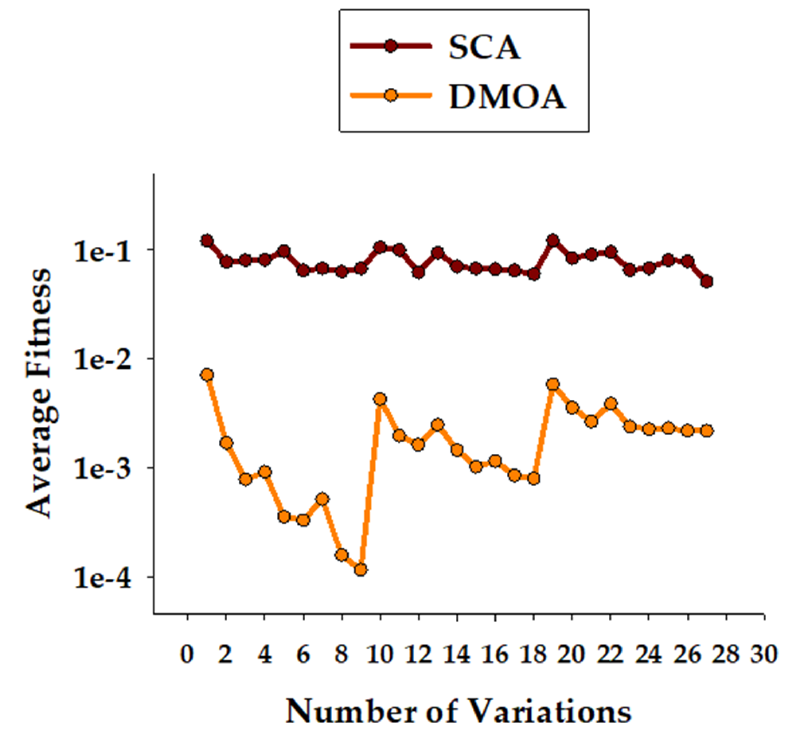
Figure 8. Kruskal–Wallis test between the DMOA and SCA, where p < 0.01.